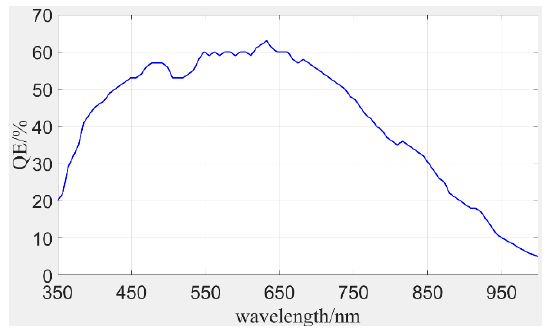
Figure 3. The quantum efficiency of the CMOS.